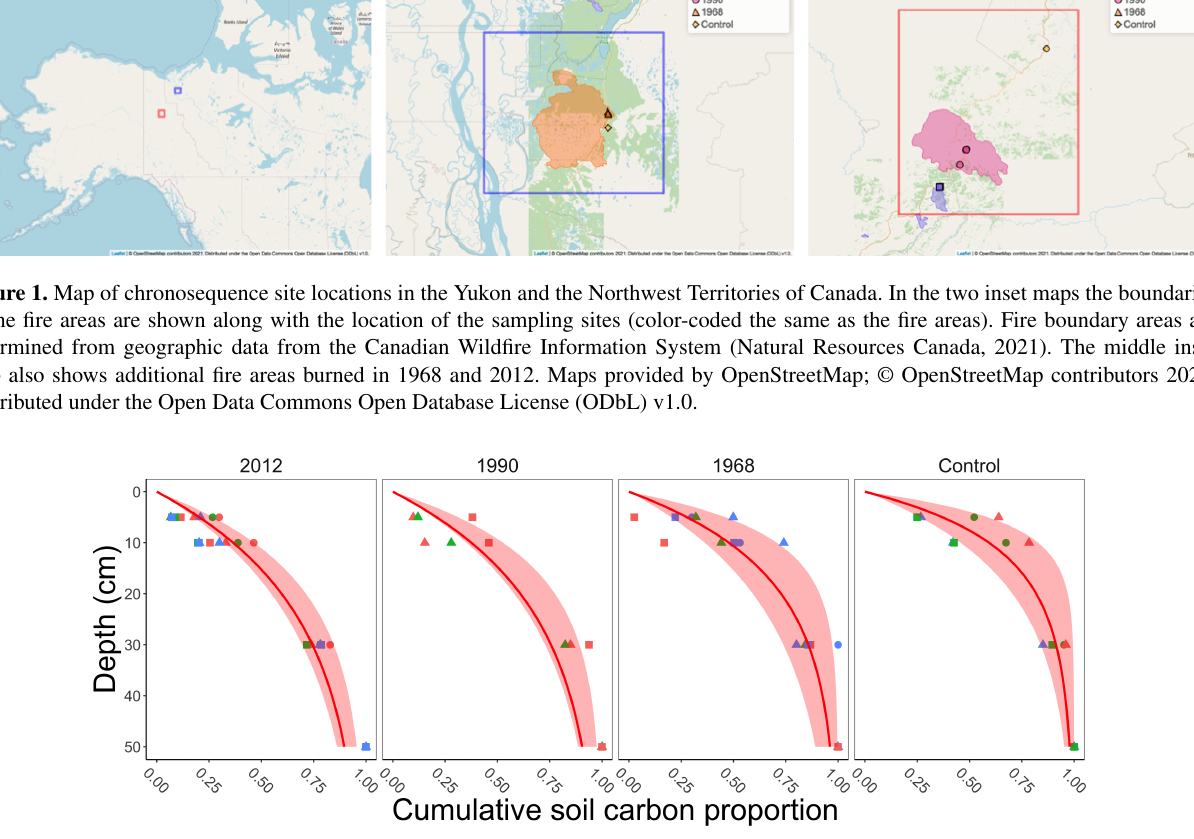
( Q 10 value) (no units) for pool X . To aid the representation of model equations, we will write Eq. (1) as R X = g X C X